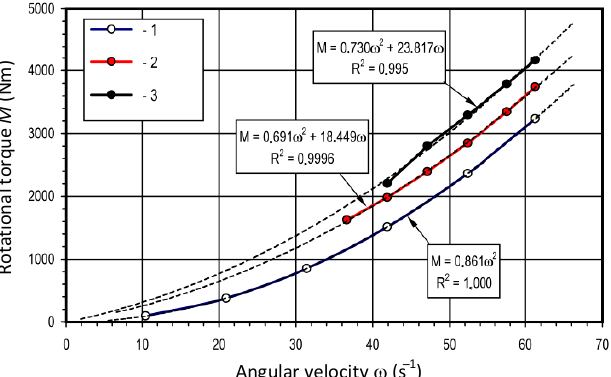
Figure 5. Waveforms of the rotational torque across the pump shaft as a function of angular velocity for: 1 — H g = 0 m; 2 — H g = 2 m; and 3 — H g = 4 m.